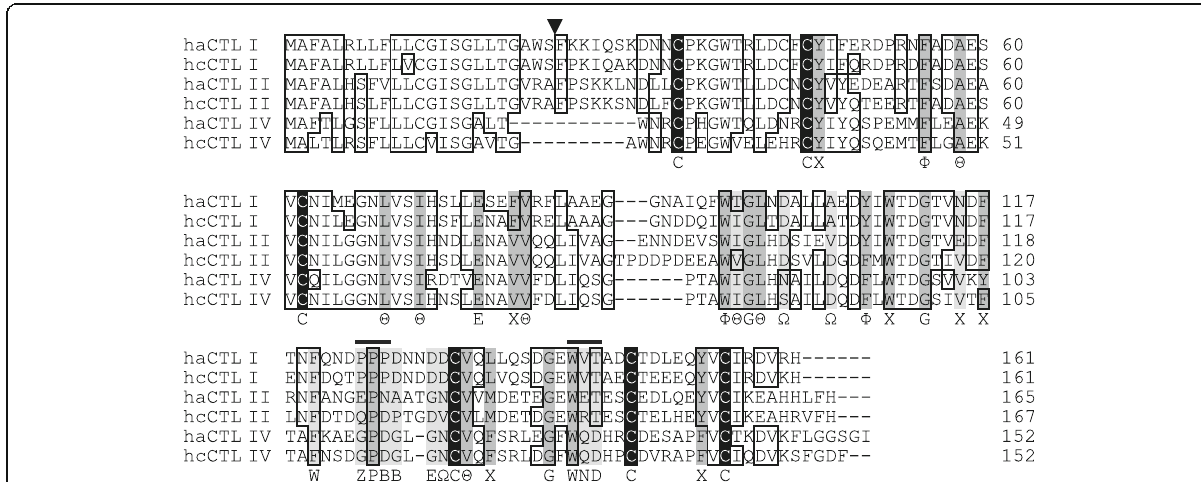
Fig. 7 Amino-acid sequence alignment of C-type lectins (CTLs). Amino-acid sequence alignment was made from CTLs of Hippocampus abdominalis (i.e., haCTL I, II, and IV) together with those of H. comes (i.e., hcCTL I, II, and IV). Identical residues are boxed; dashes represent gaps; the triangle indicates the putative cleavage site of a signal sequence. Bars above sequences indicate the part of the Ca 2+ binding site involved in sugar specificity. Conserved cysteine residues are shaded in black, and other conserved residues are shaded in dark gray; residues of the consensus motif that are not conserved in seahorse CTLs are shaded in light gray. Consensus residues of the lectins are shown below the sequences. Θ , aliphatic; Φ , aromatic; Χ , aliphatic or